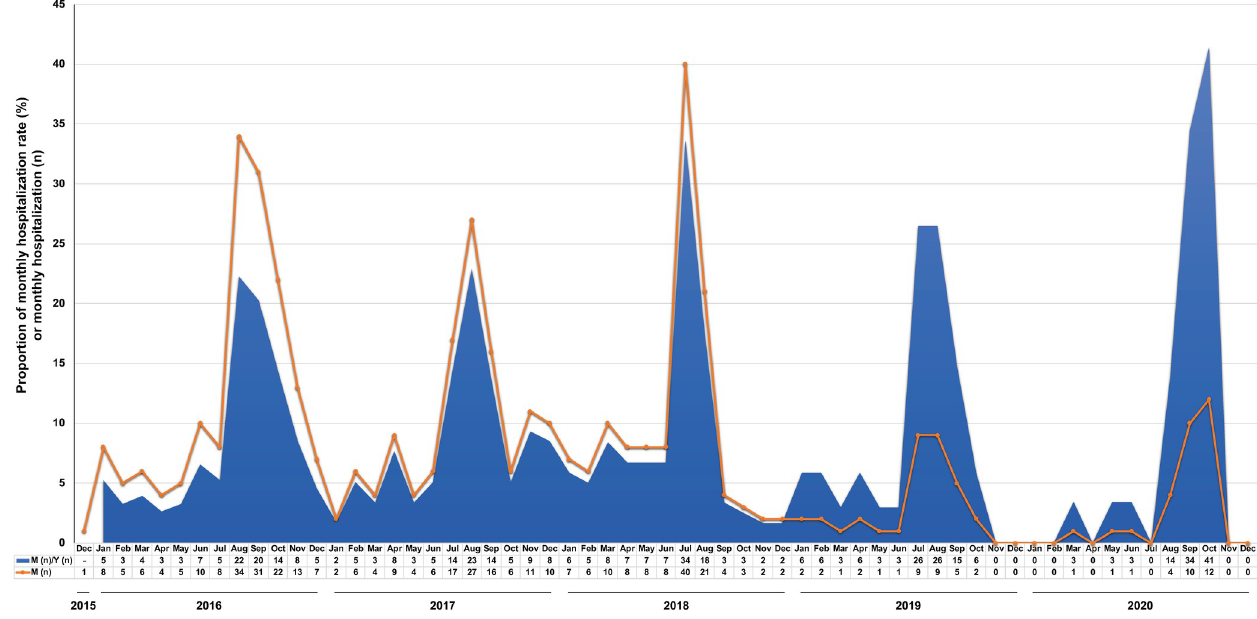
Fig 1. Hospitalization rate and number of JEV infections ( n = 454), December 2015–December 2020. M (n): number of monthly hospitalizations, Y (n): number of yearly hospitalizations.